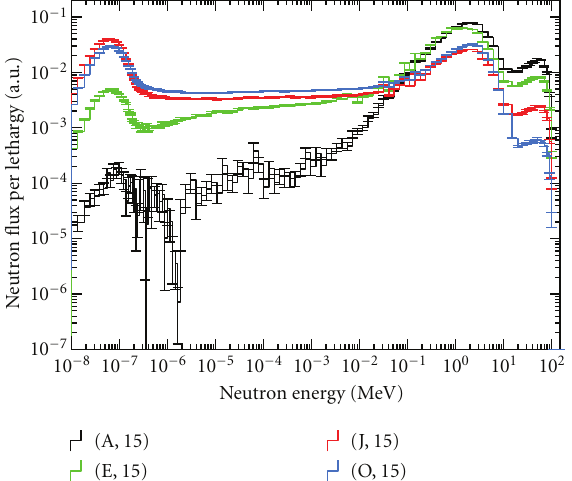
Figure 4: Comparison between neutron spectra at four points in the ADS experiments (Figure 1).